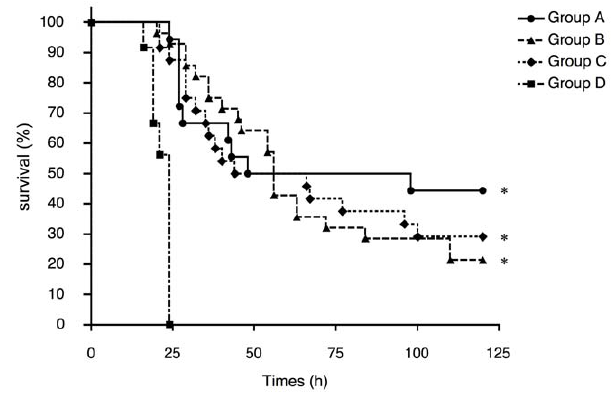
Figure 7. Protection against fatal systemic pneumococcal infections by maternal immunization with PspA among offspring. Offspring at 10-days of age were intraperitonally challenged with 1 6 10 4 CFU TIGR4 strain (100 m l/mouse) with anesthesia. After challenge, offspring were monitored for 5 days to determine survival. Group A (n=24), B (n=28), C (n=24), and D (n=38) mice were produced in the same manner as the corresponding groups in figure 3. Group A mice are offspring delivered from PspA-immunized mothers and breast-fed by the same mothers (n=24). Group B mice are offspring from sham-immunized mothers and breast-fed by PspA- immunized mothers (n=28). Group C mice are offspring from PspA- immunized mothers and breast-fed by sham-immunized mothers (n=24). Group D mice are offspring from sham-immunized mothers and breast-fed by the same mothers (n=38). * p , 0.01 when compared with control offspring in Group D by Kaplan-Meier test with Log rank